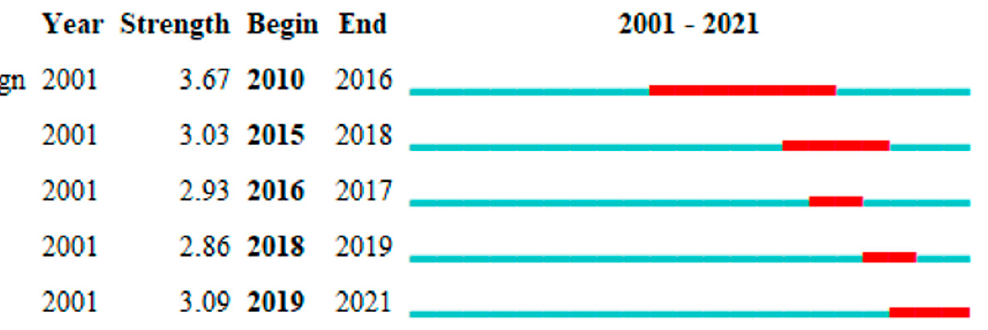
Figure 11. Top five emergent climate keywords.